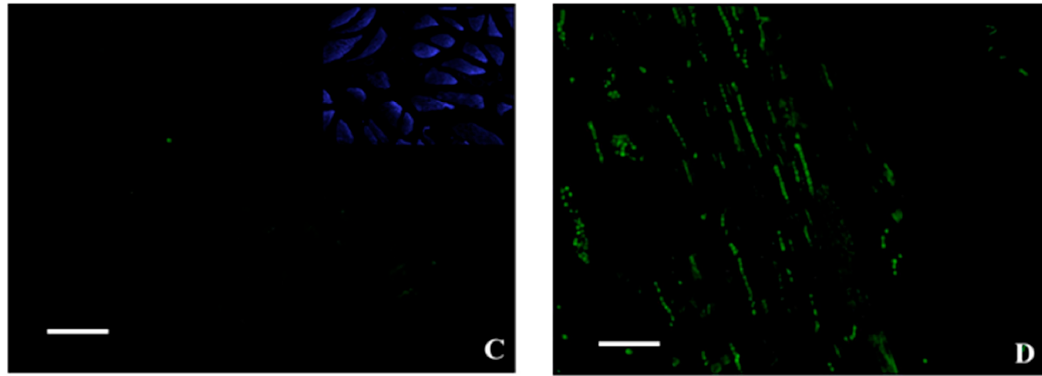
Figure 2. Representative fluorescence staining for GFP. ( A ) Image shows numerous GFP-positive fibers in a treated mouse’s hind right leg. ( B ) High GFP-signal in an electroporated skeletal muscle of a mouse’s hind right leg. ( C ) Image displays no/rare GFP-positive fibers in a control mouse’s hind right leg. Square shows DAPI-signal. ( D ) Very low GFP-signal in a control mouse’s hind right leg; note a background signal (erythrocytes) in a negative region. Scale bar represents 100 µm for all images.